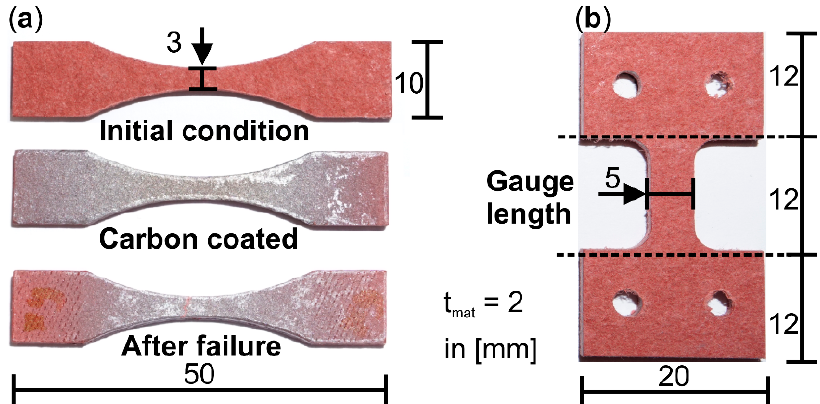
Figure 1. Specimen geometry for in situ tensile tests in ( a ) scanning electron microscope (SEM); and ( b ) microfocus computer tomograph ( µ CT).